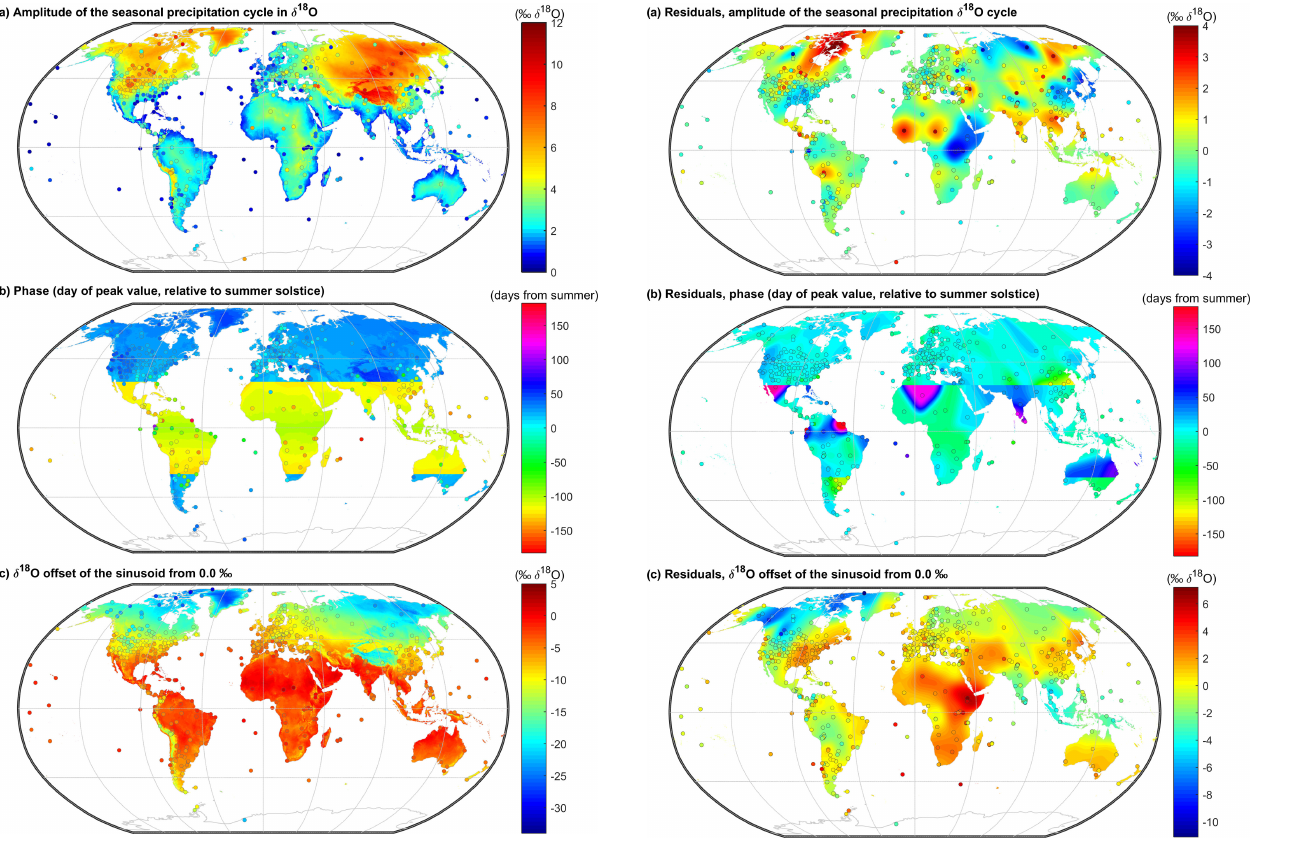
Figure 5. Maps of δ 18 O (a) amplitude, (b) phase, and (c) offset residuals, where the sine parameter values predicted from the mul- tiple regression equations (shown in the interpolated maps in Fig. 4) were subtracted from those of parameter values fitted to measure- ments at each precipitation isotope monitoring site (also shown in Fig. 4). The shading shows the smoothed residual layers (see Meth-